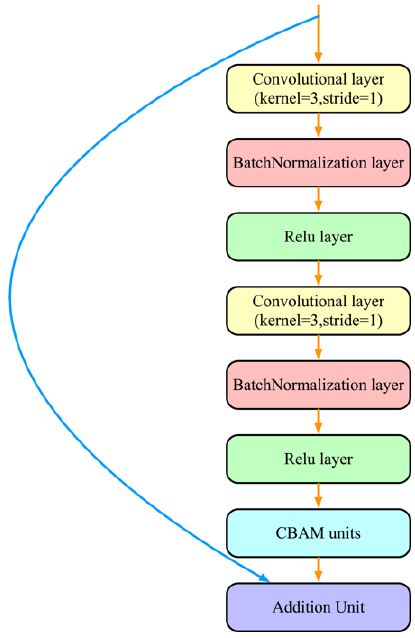
Figure 8. Res-Conv unit